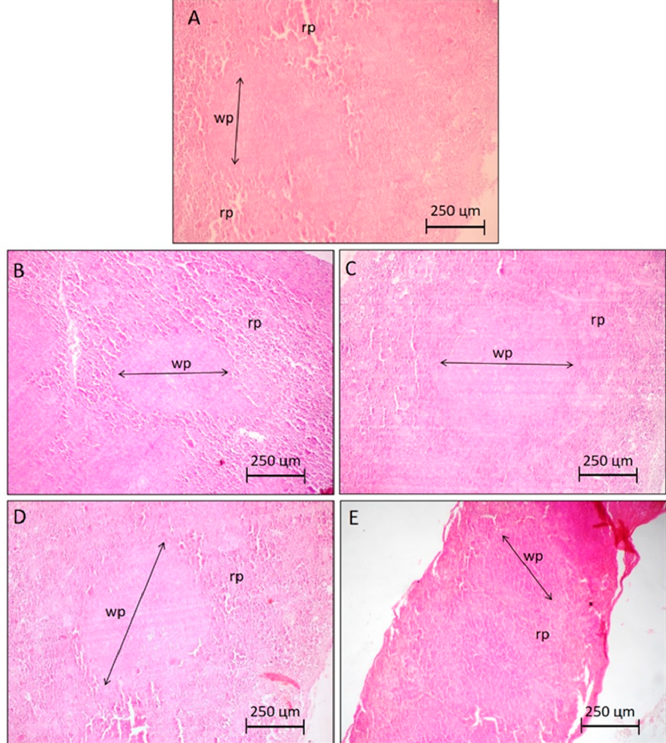
Figure 6. Photomicrographs representative of the spleen histology (5 µm) of groups of animals without and with S180 tumor, highlighting the limits of the white pulp (wp) and red pulp (rp). Control groups ( A,B ) are animals without and with tumor S180 treated with the vehicle (saline), respectively. Groups ( C , D) are S180 tumor-bearing animals treated with PaLE 100 and 150 mg/kg/day, respectively. The positive control group ( E ) are S180 tumor-bearing animals treated with 5-fluorouracil 25 mg / kg / day. 100 ×